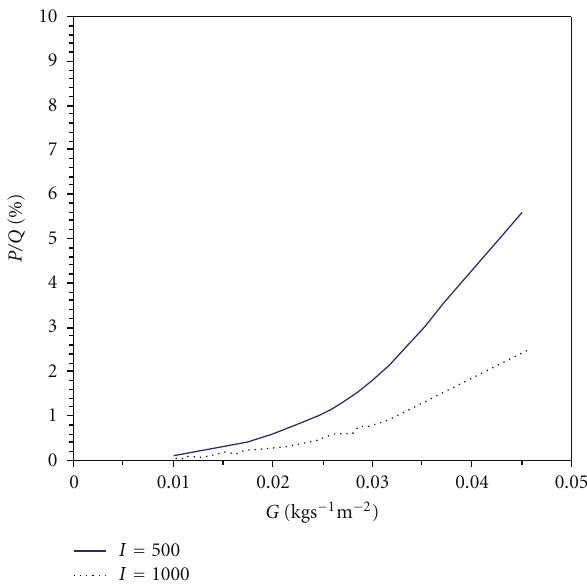
F 9: Pumping power as percentage of the heat collection